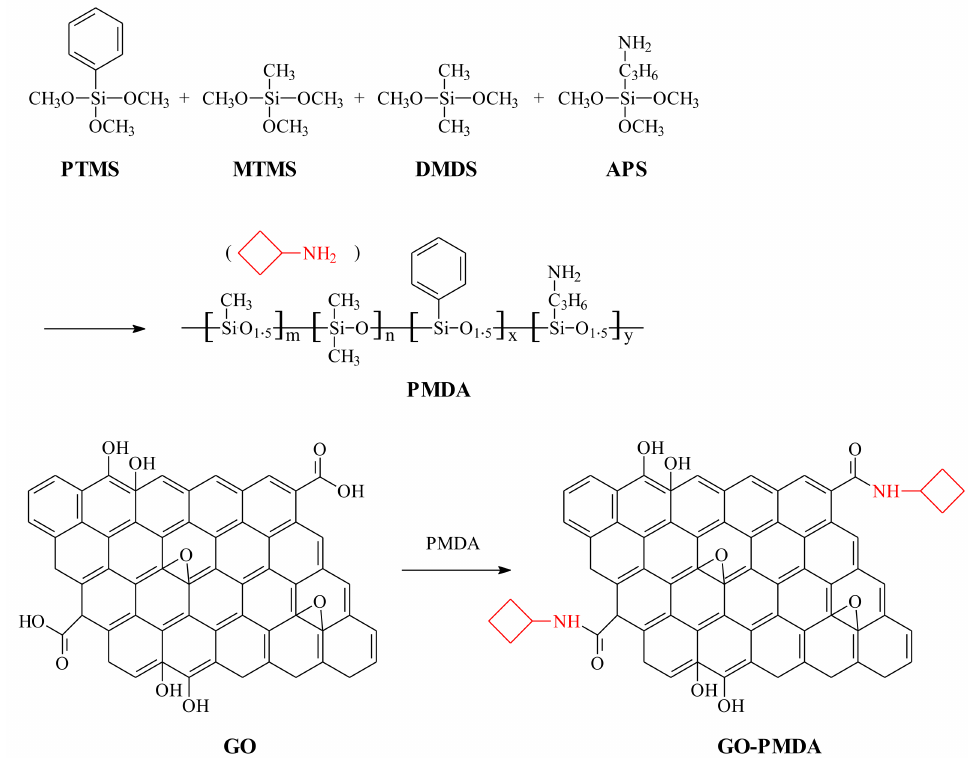
Scheme 1. Synthesis route of